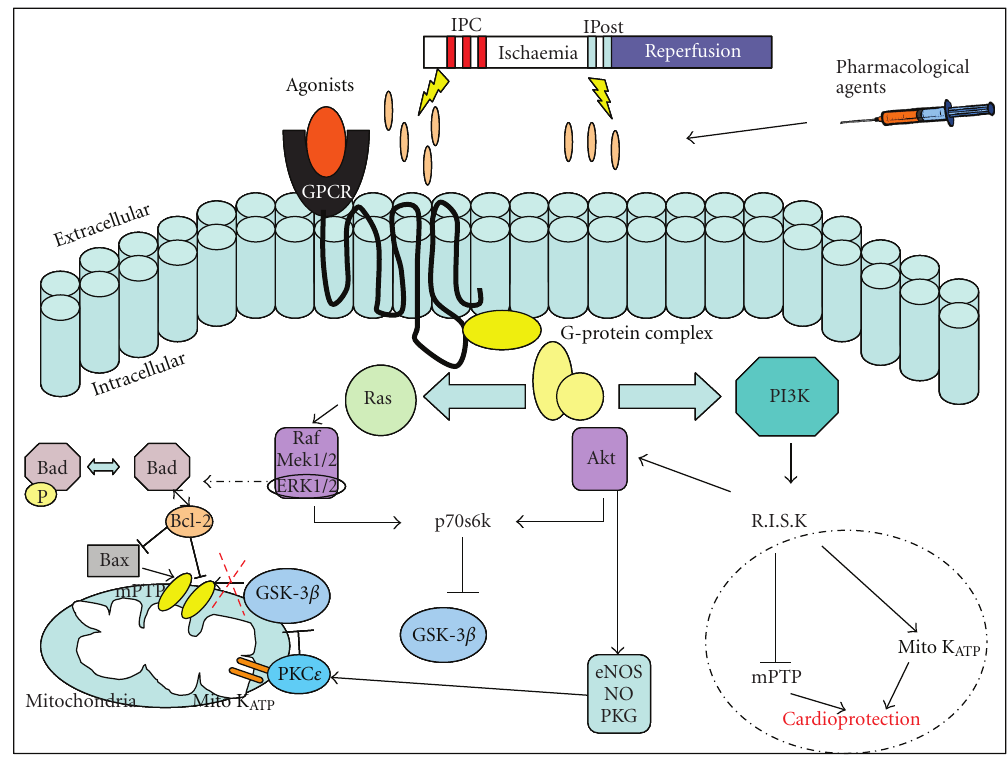
Figure 3: The cellular mechanisms involved in Ischemic Preconditioning. IPC, IPost, or pharmacological agents initiates the release of G-protein-coupled receptor (GPCR) agonists which bind to the receptor and activate numerous signaling pathways. Phosphatidylinositol- 3-kinase (PI3K) and Ras activation can lead to activation of a number of downstream molecules such as Akt, protein kinase C (PKC), extracellular regulated kinase (ERK), nitric oxide synthase (NOS), and inactivation of glycogen synthase kinase-3 β (GSK-3 β ). These converge to activate the mitochondrial ATP-dependent potassium channel (K ATP ), closing the mitochondrial permeable transition pore (mPTP) resulting in protection from IRI